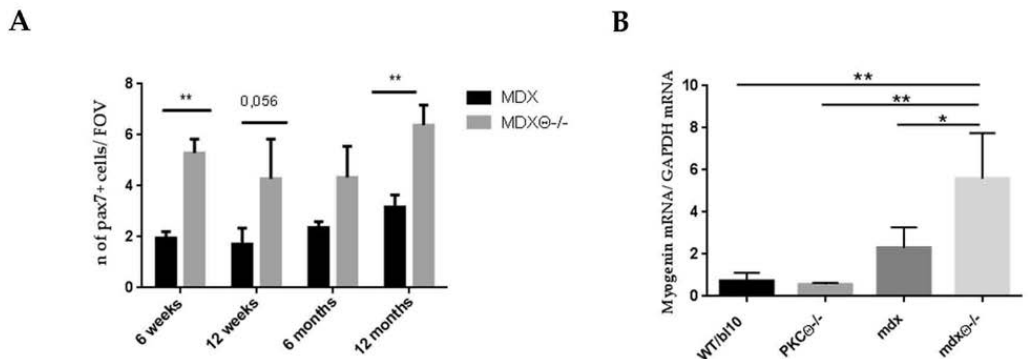
Figure 3. ( A ) Number of Pax7 + cells in TA section of mdx and mdx θ − / − mice at 6 and 12 weeks, and